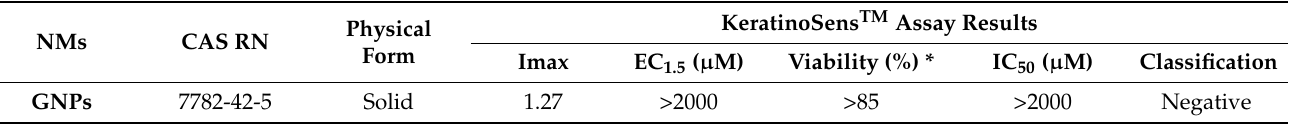
Table 3. GNPs evaluated in KeratinoSens TM